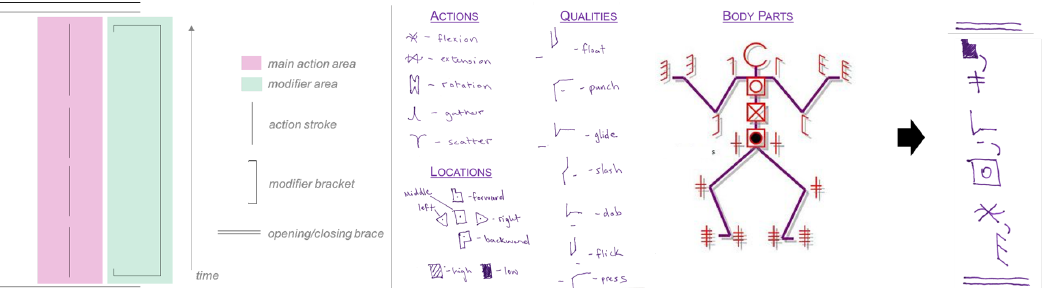
Figure 3. The diagram at left shows the structure of a vertical Motif (shown at right). The center column of a Motif denotes the main action. The length of a stroke indicates relative duration. These generic strokes may be replaced with more complex symbols (shown in center). The green area to the right, which may also be called a theme bow, allows for the main action to be modified, possibly highlighting overarching themes in the phrase. The sequence of action moves from bottom to